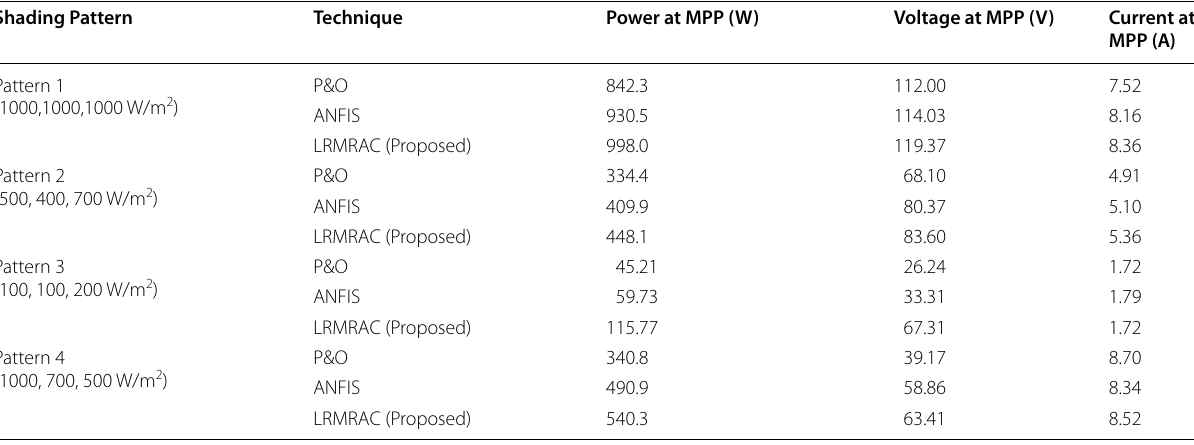
Table 5 Steady-state response of different MPPT approaches under study Shading Pattern